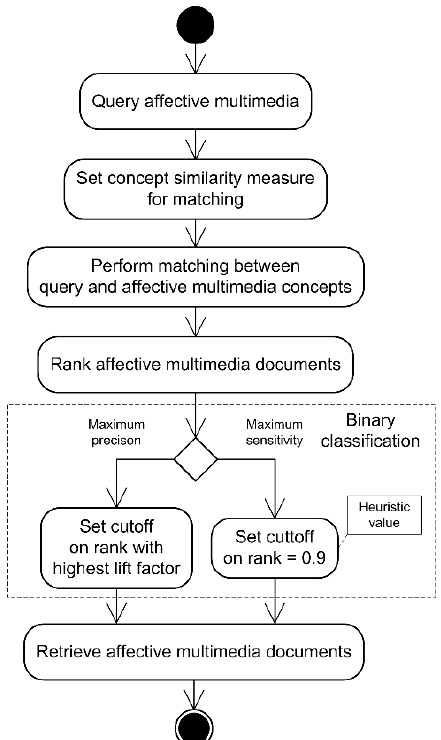
Figure 7. UML activity diagram of the affective multimedia retrieval process based on lift charts and used in the experiment.